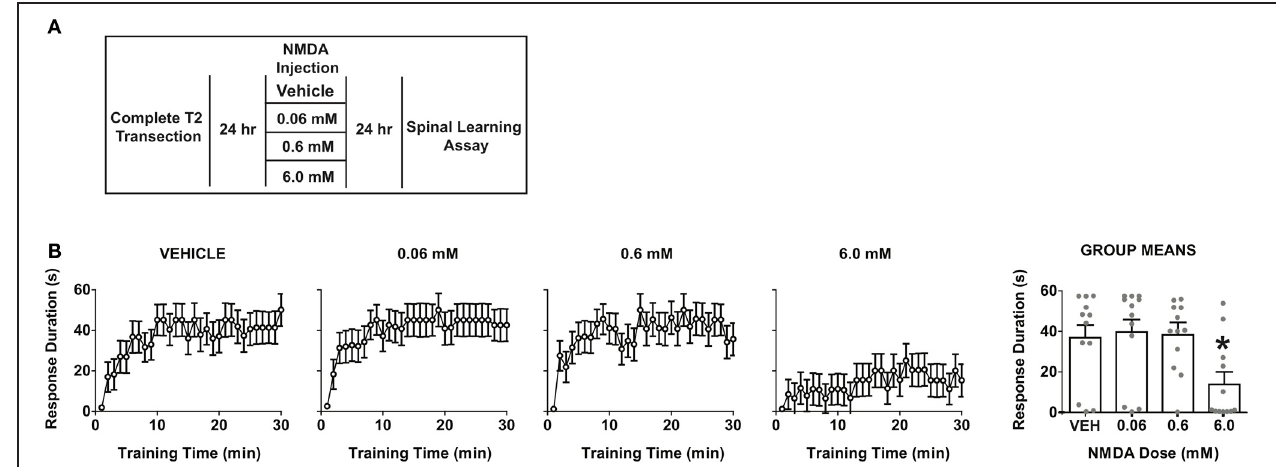
FIGURE 6 | Direct overactivation of spinal NMDA receptors impairs spinal learning 24h later. (A) Experimental design used to test the effect of intrathecal NMDA on spinal learning potential 24h after delivery. (B) Dose-response function for NMDA-induced impairment of spinal learning. Mixed-repeated measures ANOVA revealed a significant effect of